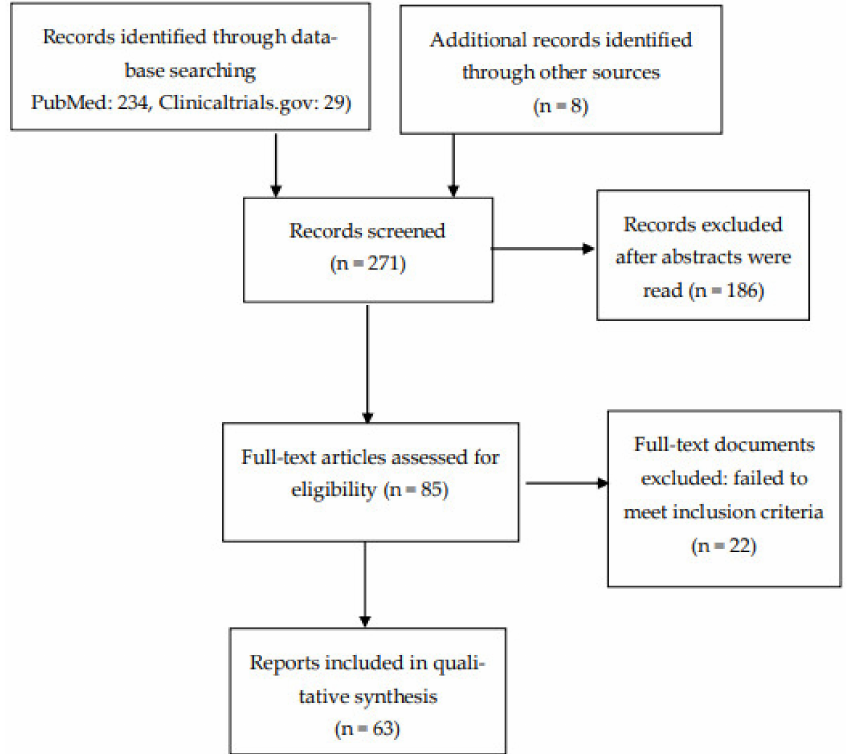
Figure 1. Flow diagram of included